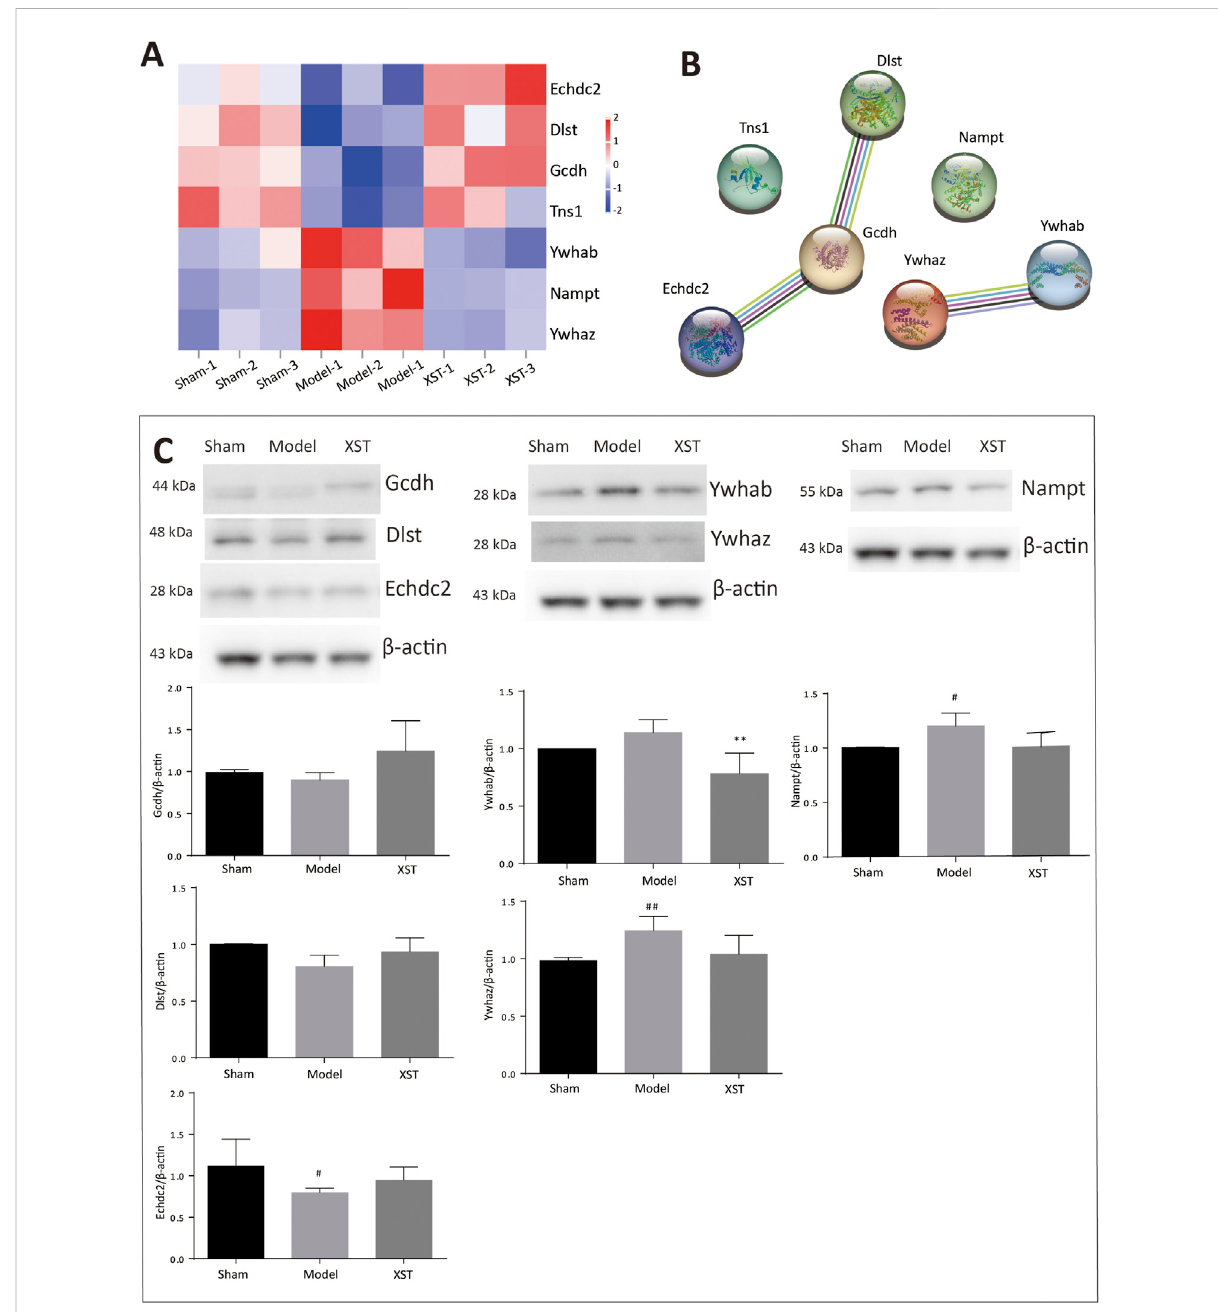
FIGURE 7 (A) Hierarchical analysisofsevensharedDEPsinSham:ModelandModel:XST.Blueindicatesanegativecorrelation,andredindicatesapositive correlation. The darker the color, the more substantial the alteration is. (B) Protein – protein interaction network. (C) Effect of XST on AMI-induced alteration in six critical DEPs by Western blotting validation. n = 3. # p < .05, ## p < .01 vs. the sham group, and ** p < .01 vs. the model